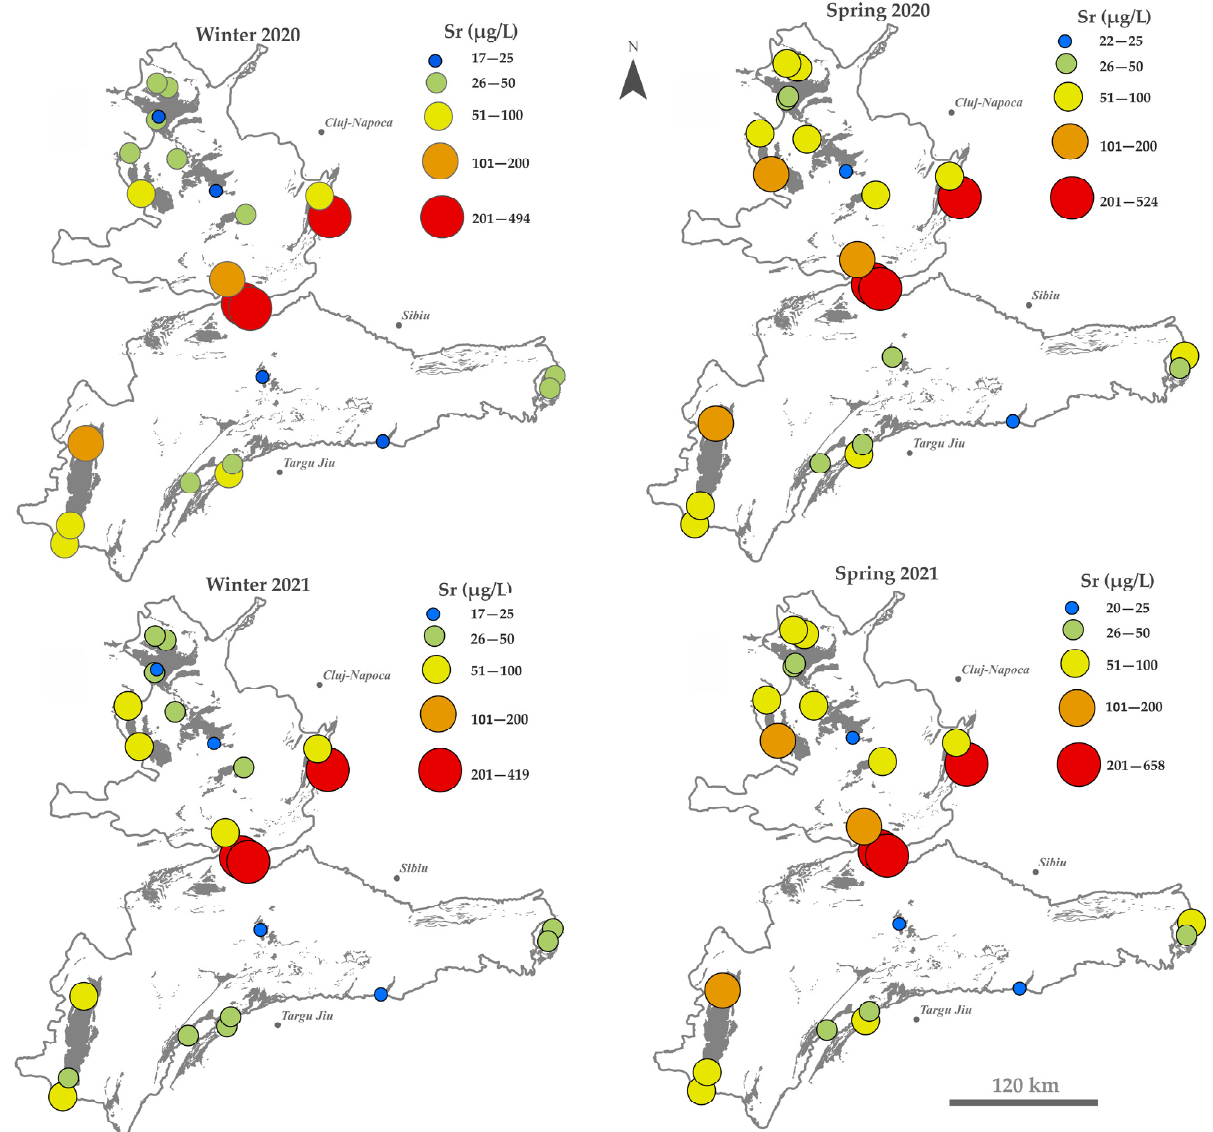
Figure 2. Concentration of Sr (µg/L) in groundwaters from the Southern Carpathians (SCP) and Apuseni Mountains (APS) karst areas.